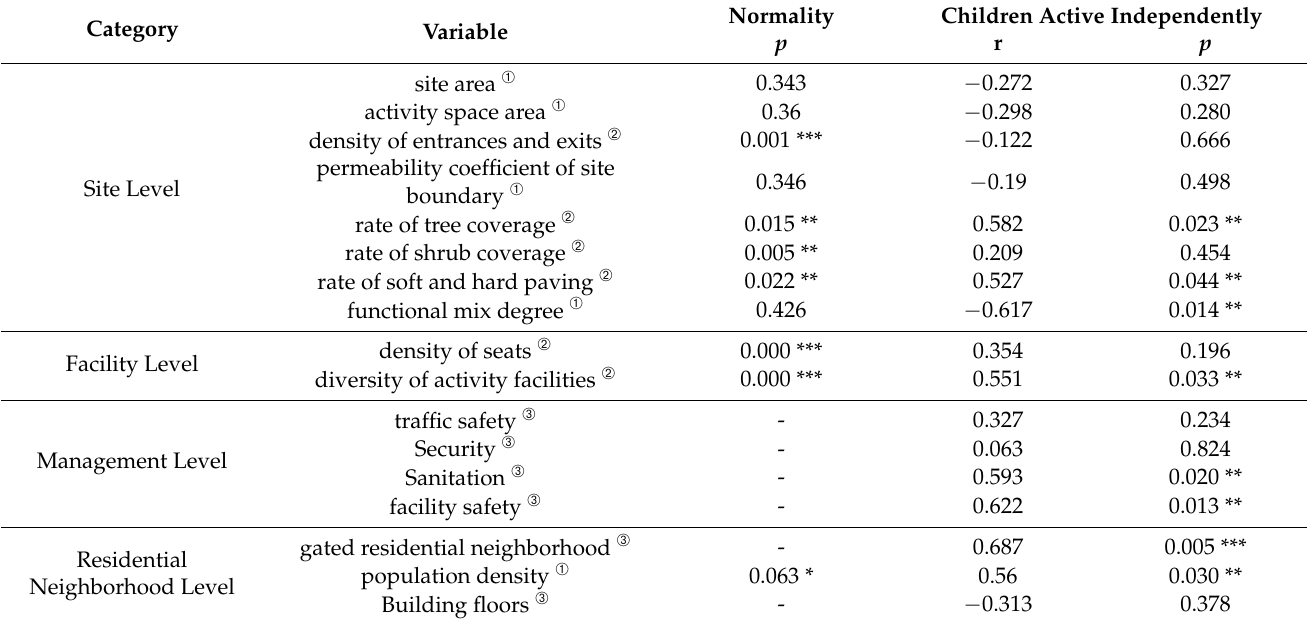
Table 8. Analysis of the correlation between CIAs and the built